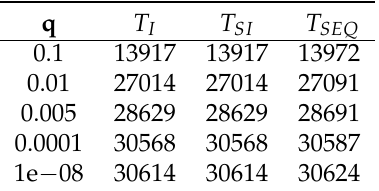
Figure 4. Hydrate saturation at T = 31 K when different advective fluxes are assumed. For q = 0.1 for which high saturation is attained already at T = 25 K we do not show the plot at T = 31 K . Table 4. The time T when max S h ≈ 0.5 depending on q , for the base case for each time-stepping variant, respectively, T I , T SI , T SEQ . Here we use τ = 1.